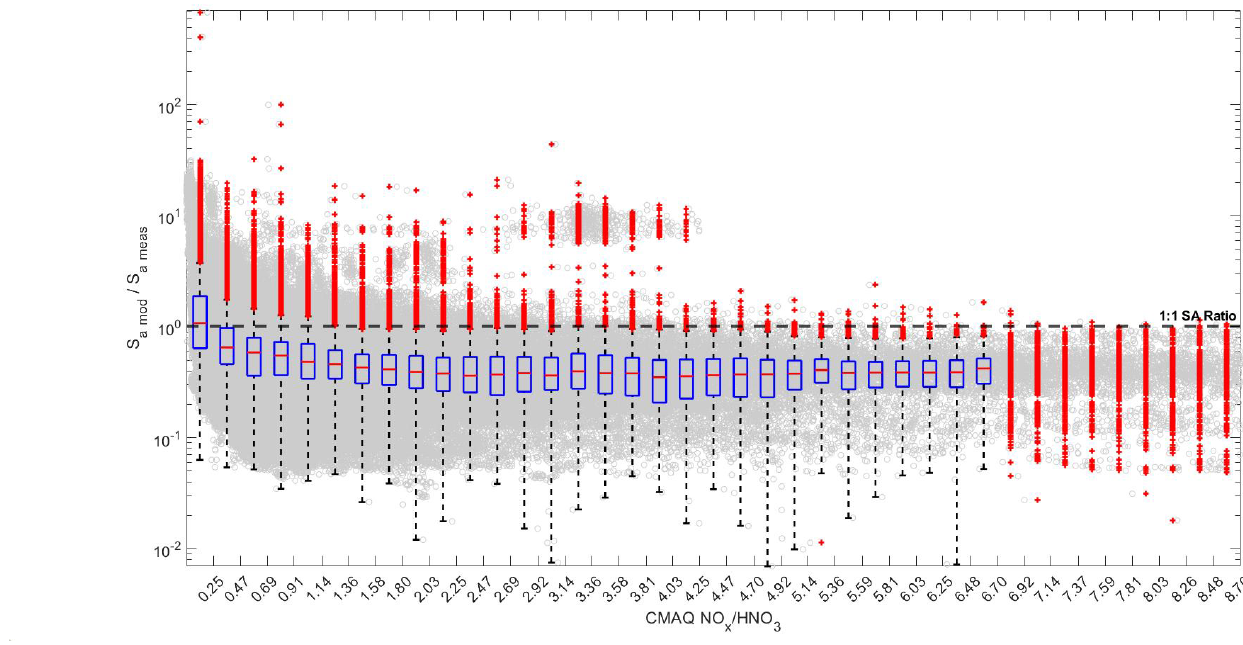
Figure 12. Interquartile ranges in S a , mod /S a , meas as a function of the modeled (CMAQ) NO x / HNO 3 concentration